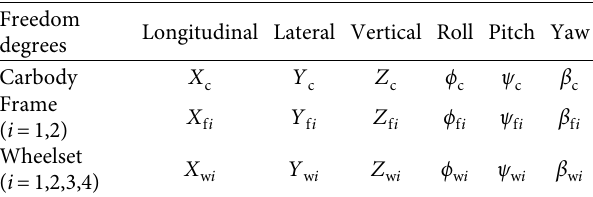
Figure 12: Vehicle dynamics simulation model. Table 2: Freedom degrees of vehicle dynamics